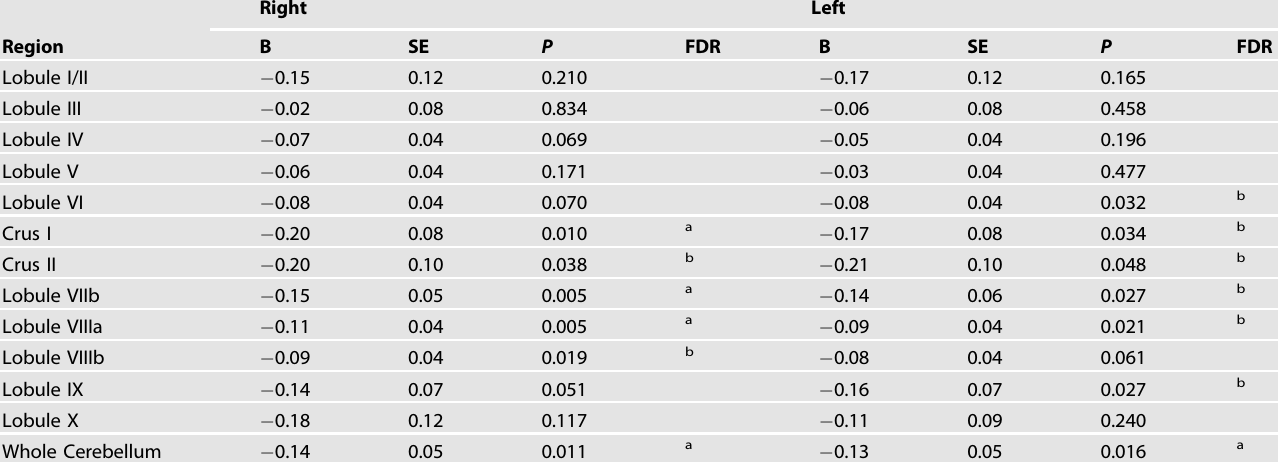
Table 2. Asymmetric differences in cortical thickness by cerebellar subregion and whole cerebellum. Right Left